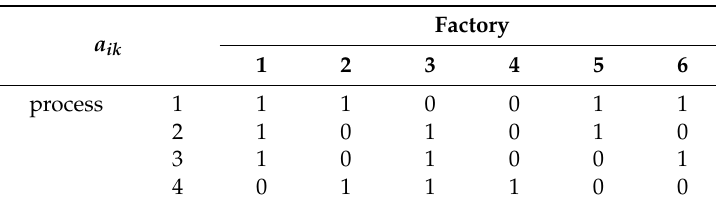
Table 4. Set covering